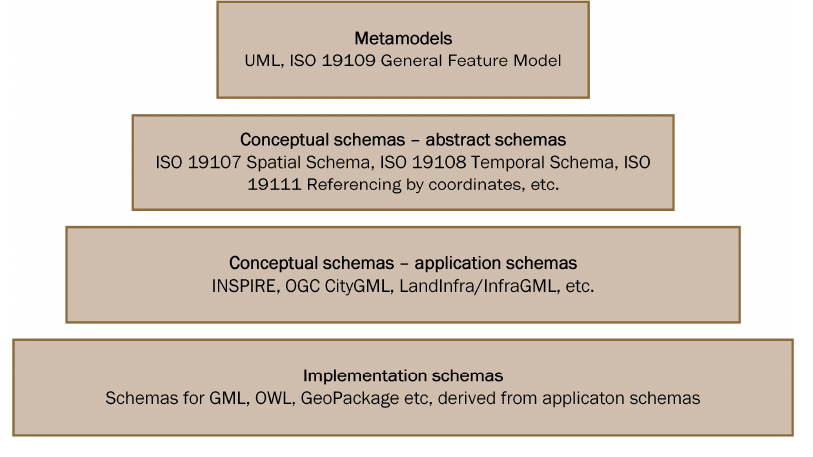
Figure 2. The levels of abstraction in model driven architecture according to ISO 19103 [14].